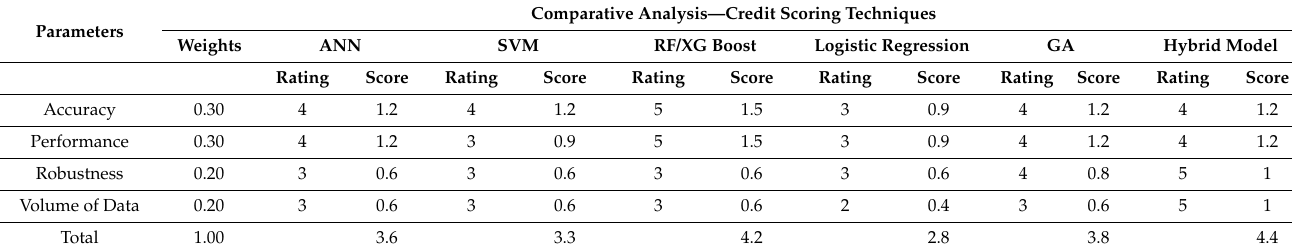
Table 5. Comparative analysis of credit scoring